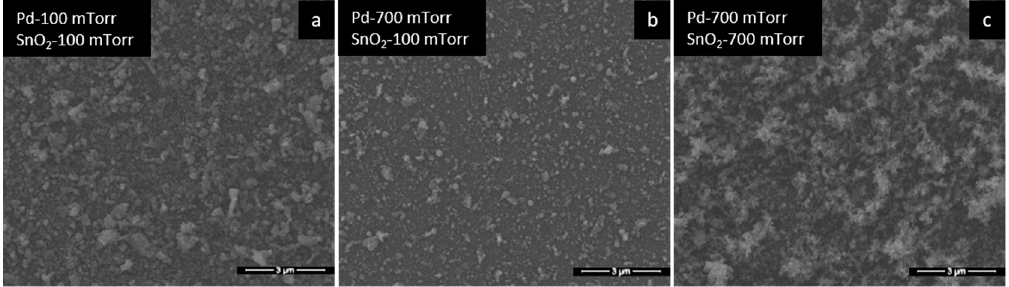
Figure 5. SEM images of Pd/SnO 2 films at different gas pressures.